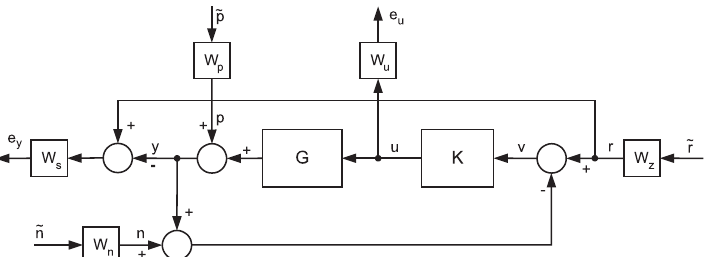
Figure 4. The block diagram of the closed-loop system with the plant with uncertainties and weighting functions for selected signals. The meaning of the particular signals is as follows: ˜ r = references vector, ˜ p —vector of disturbances, ˜ n —noises vector, ˜ e y —weighted control errors, ˜ e u —weighted control